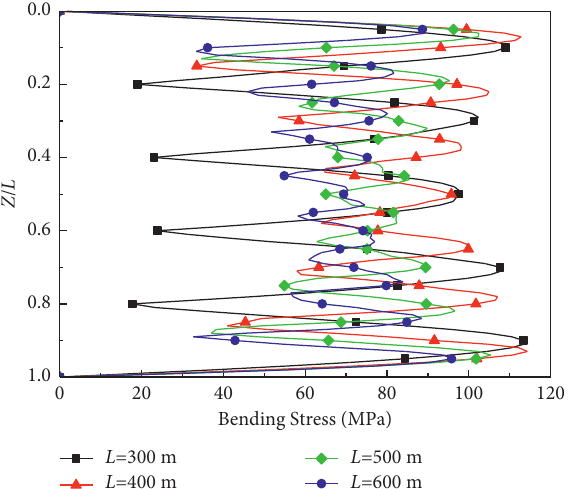
Figure 15: VIV bending stress distribution of riser under different riser